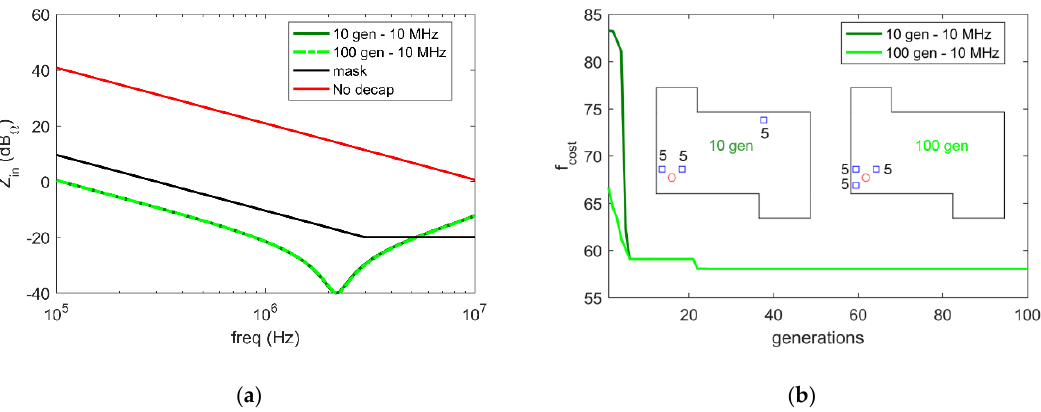
Figure 13. ( a ) Result of the optimization in EZpp up to 10 MHz after 10 generations (solid green line) and 100 generations (dotted–dashed light green line) compared with the mask and the case without decaps. ( b ) Cost function f cost as function of the number of generations when max gen = 10 and max gen = 100. The insets show the decaps placement after as max gen changes its value and the number of elementary decaps in each position. The red circle represents the input port and the blue squares the position for the decaps. Table 5. Best solution provided by DF PI and EZpp for the optimization of decaps value and position, changing the maximum optimization frequency ( f max ) and the maximum number of generations ( max gen ). f max